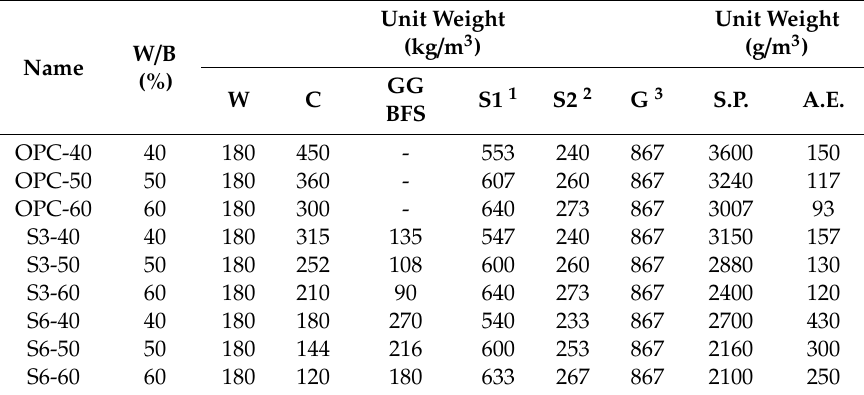
Table 2. Concrete mix proportion.